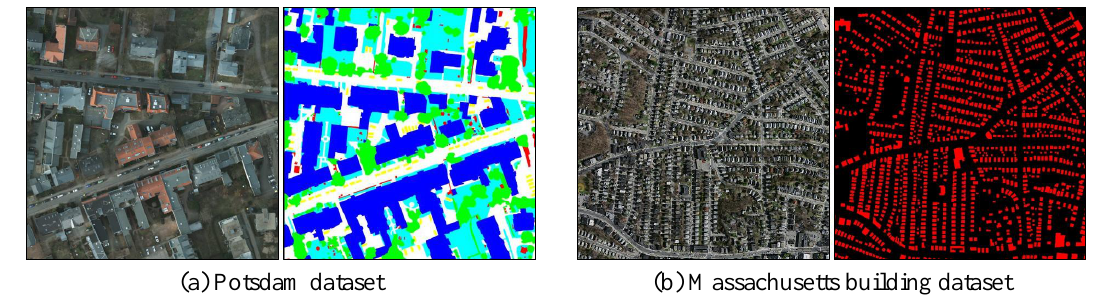
Figure 2. Example images and their manually segmented ground truths in he Potsdam dataset (six categories: impervious surface, building, low vegetation, tree, car and clutter) and the Massachusetts building dataset (two categories: building and